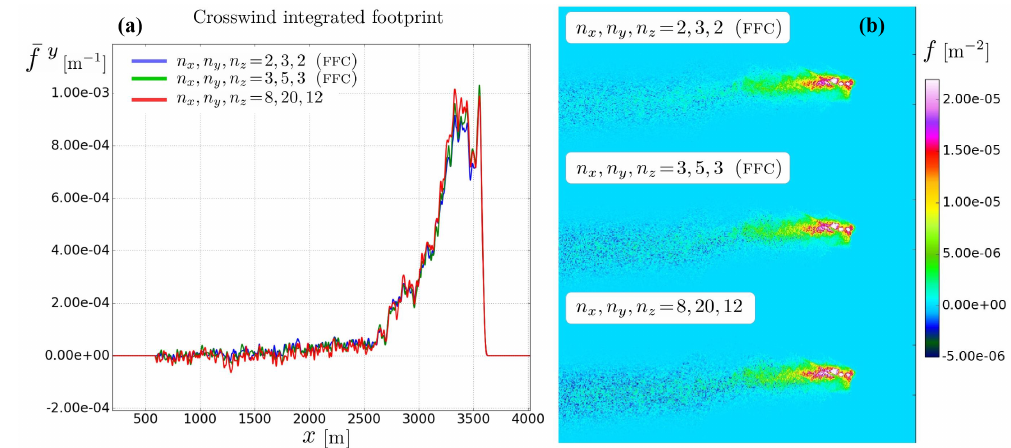
Figure 7. Comparison of identically normalized footprint distributions (b) and their crosswind integrations (a) obtained either by applying (1) the far-field correction ( FFC ) method and selective assembly or (2) the standard coordinate rotation while utilizing the uniform 1m resolution of the LES grid in the target volume discretization. The subvolume contributions included in the n x ,n y ,n z = 8 , 20 , 12 result were = P = 3 , 5 , selected to correspond with the effective target volume V i,j,k ∈ K V i,j,k determined via the selective assembly for n x ,n y ,n z T , eff